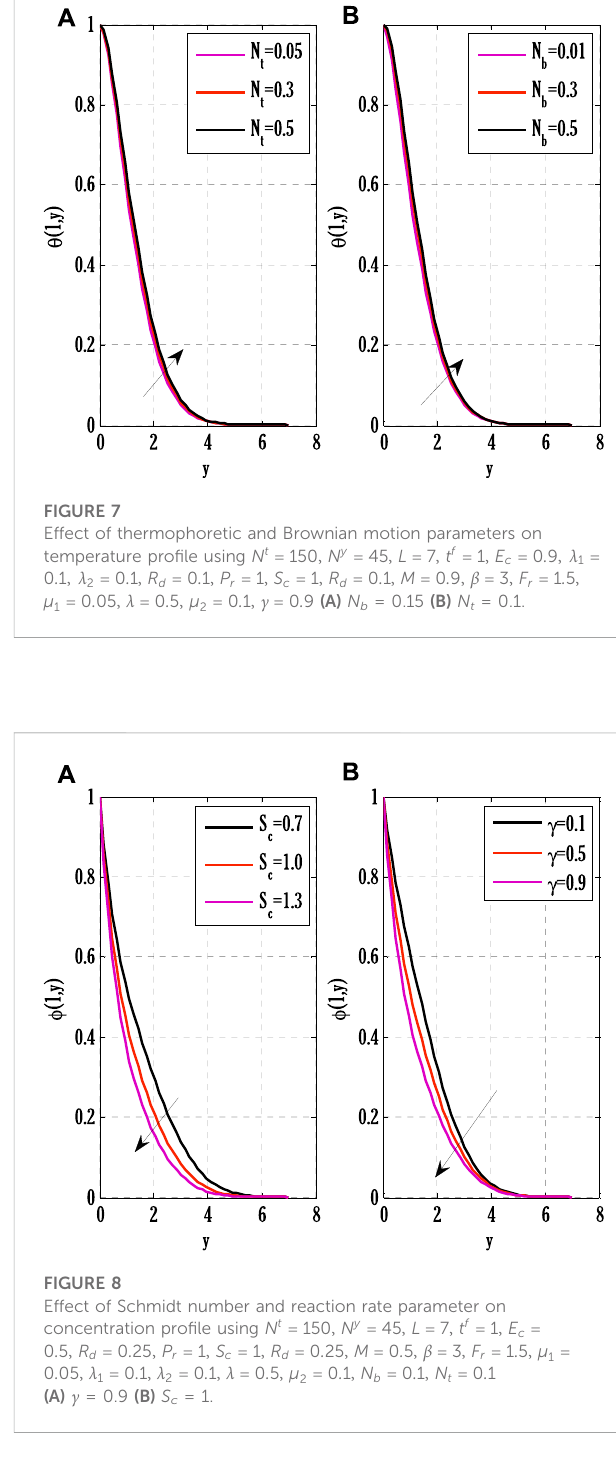
ofthe solutionthatdependsonthenumerical valuesof chosenparameters and values of step sizes in some particular interval. Figure 2 deliberates comparing the proposed scheme with the existing Crank-Nicolson scheme. The maximum of norms for the solution of each Eqs.61 – 64iscomputed. Thenormforthedifferencebetweentwosolutions computed at two consecutive iterations is found, and a maximum of three norms over each iteration is displayed in Figure 2. From this Figure 2, it can be observed that the proposed scheme converges faster than the existing scheme. Since the proposed scheme gives third-order accuracy in time and